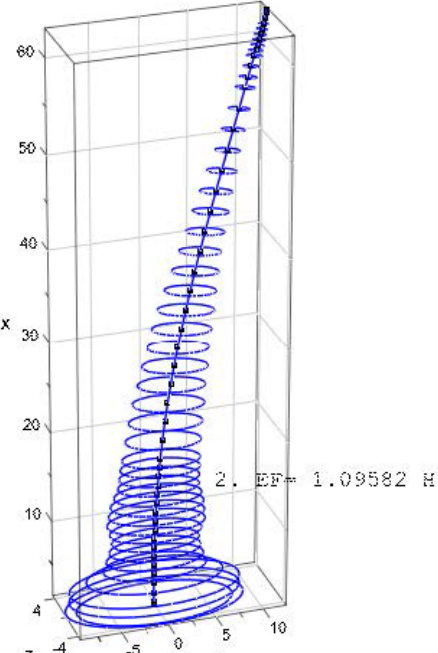
Figure 5. First flapwise eigenmode.